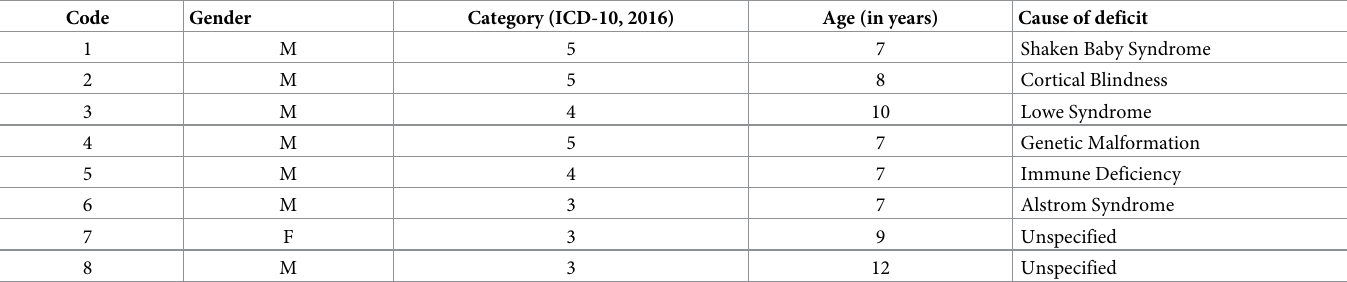
Table 3. Characteristics of early blind children and children with low vision who participated in Experiment 2: Identification of action objects in textured pictures.